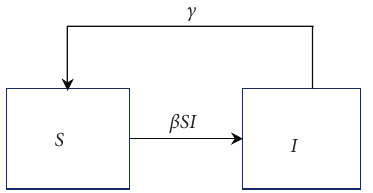
Figure 1: Schematic diagram of SIS model state